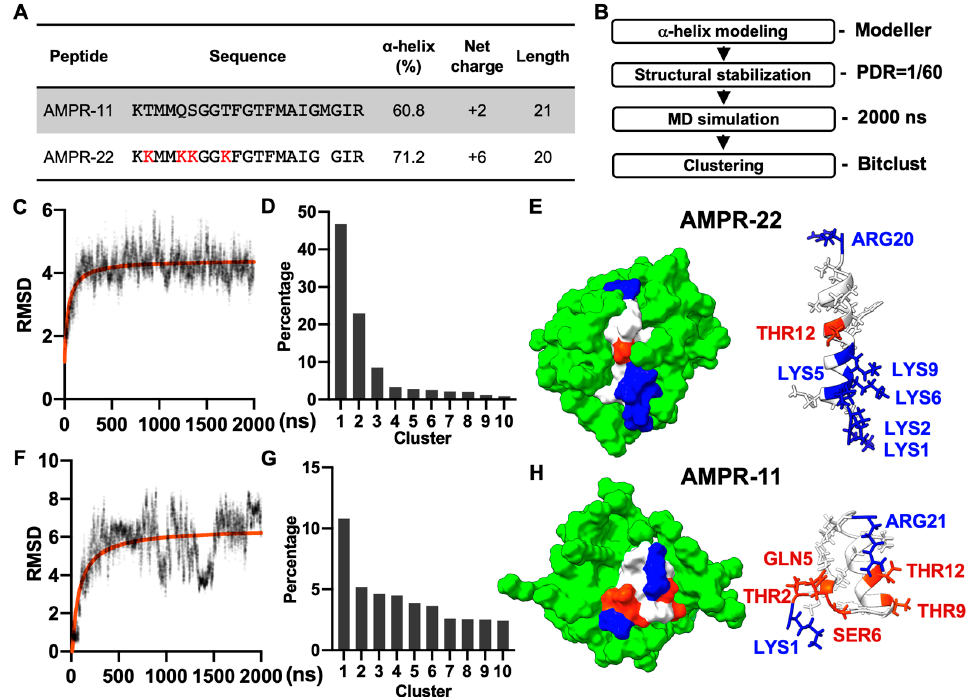
Figure 1. MD simulation of AMPR-11/22 in DPC micelles. ( A ) The amino acid sequence and chemicophysical properties of AMPR-11/22. The alpha helix proportion was calculated using the values from circular dichroism (CD) via the BeStSel server. ( B ) Experimental workflow for structure determination through MD in DPC micelles [Peptide detergent ratio (PDR) is 1/60]. ( C , F ) RMSD fluctuations of AMPR-22/11 by time. ( D , G ) Clustering of AMPR-22/11 structures in 0.5–2 µs (15,000 frames). ( E , H ) Representative structure of AMPR-22 or AMPR-11 reconstituted with DPC micelles. The hydrophobic (nonpolar), hydrophilic (polar), and cationic residues are shown in white, red, and blue, respectively. RMSD, root mean square deviation.